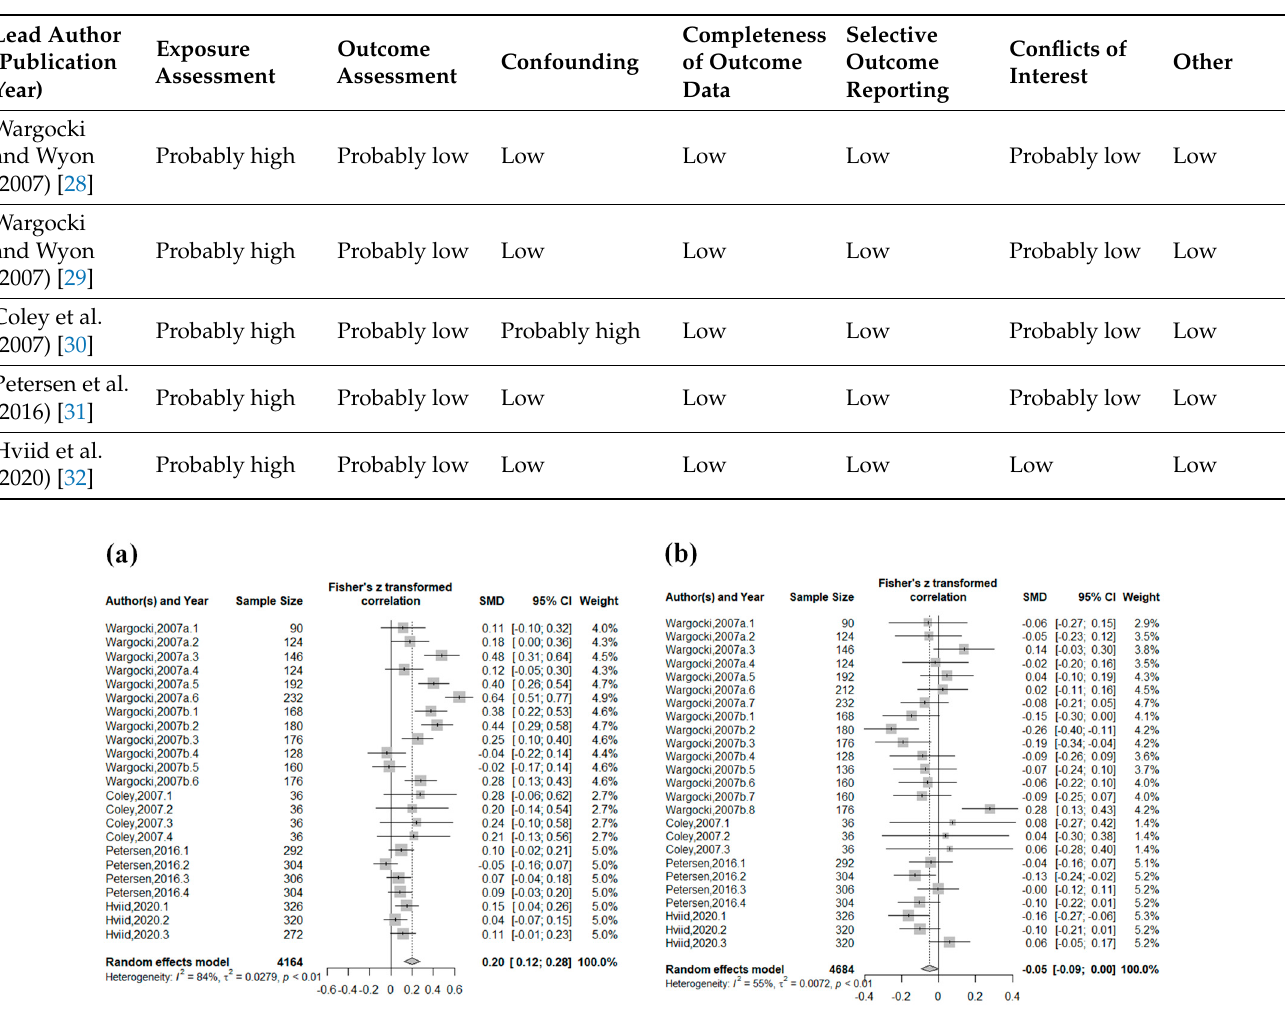
Figure 2. Association between the increase in ventilation rates and performance of school tests: ( a ) the task performance speed; and ( b ) the error rate.